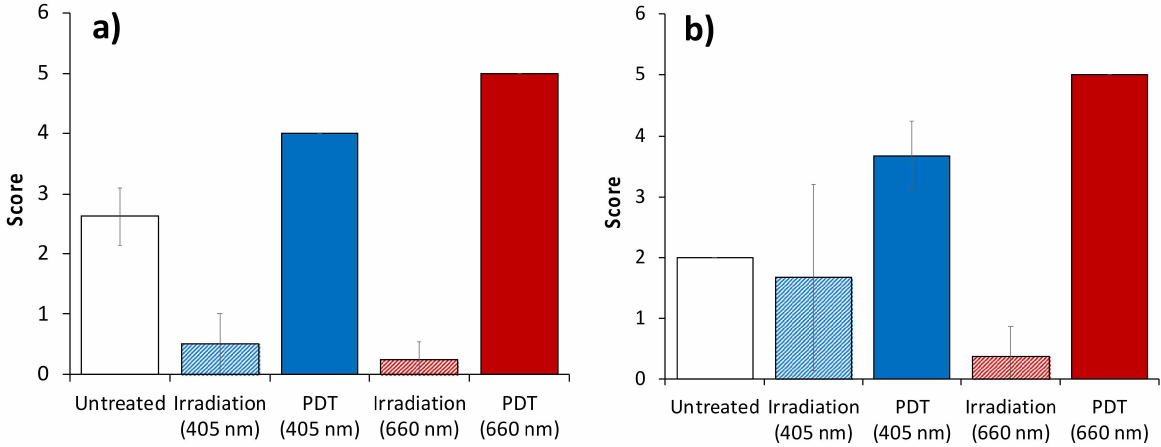
Figure 8. Scores for myocyte fragmentation ( a ) and microcirculatory system disorders ( b ) in periph- eral normal tissues calculated from histology. The data presented as M ±